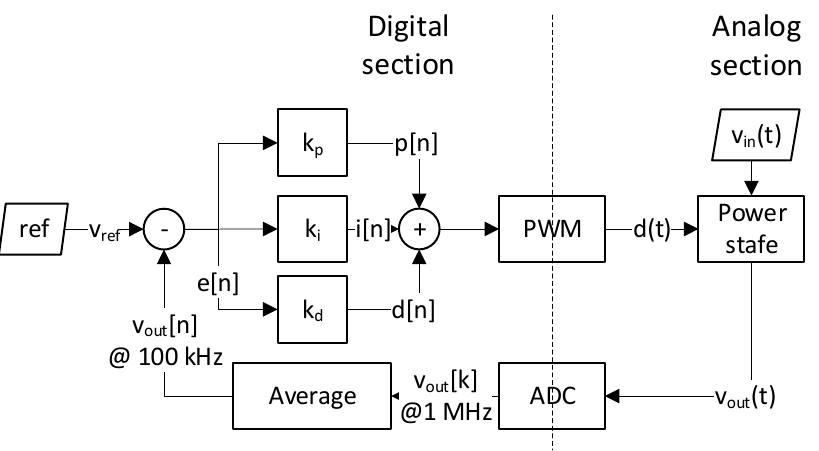
Figure 7. PID controller and a buck converter’s power stage simulation.